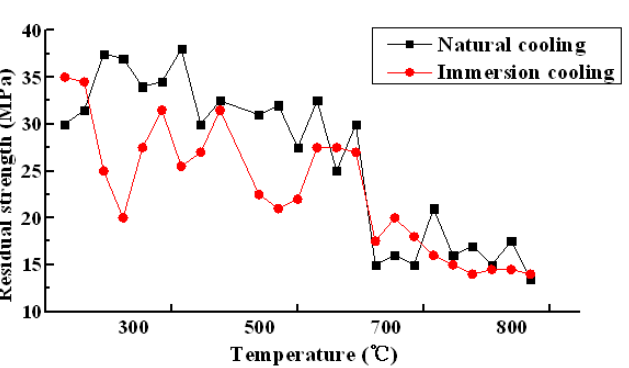
Figure 16. Residual strength of concrete under different cooling modes in a high-temperature envi- ronment [88].